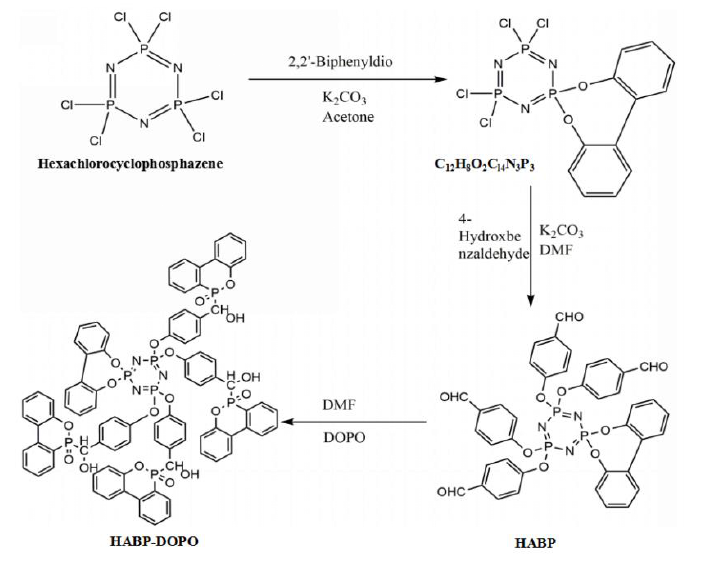
Figure 1. Preparation route and structure of HABP-DOPO.